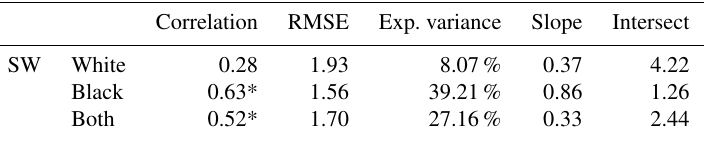
Figure 5. Correlation coefficients between the mean wind speed and the dune thickness (lt-layer thickness) of the white layer (white), black layer (black), and both together (grey). The correlations are shown for winter (DJF), spring (MAM), the windy season (SONDJFM), autumn (SON), and the eight wind directions. Table 1. Correlation, root mean square error, and explained variance values (obtained with leave-one-out validation) used to compare pre- dicted and actual number of days per wind direction. The prediction is based on dune layer thickness, which is identified to have a linear relation with SW winds between 3 and 5ms − 1 . The correlations marked with ∗ are significant at the 95% level. The last two columns show the slope and intersect of the linear regression between SW winds and layer thickness if no LOOM is